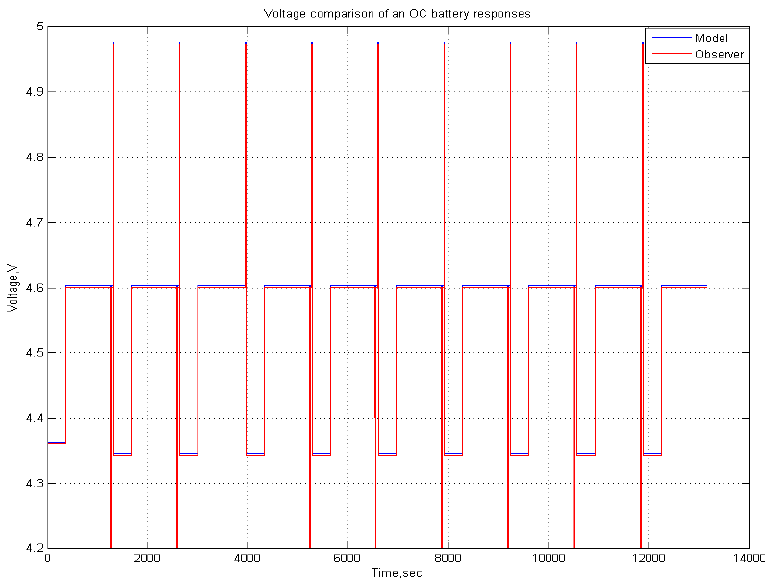
Figure 7. Model and observer response differences for OC battery operation.